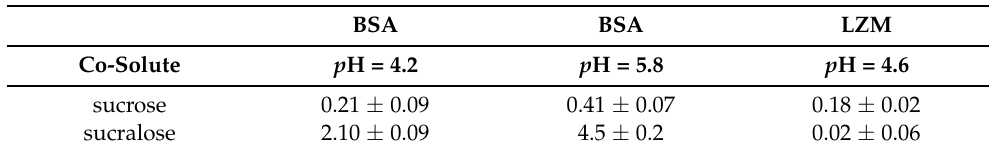
Table 2. Stern-Volmer quenching constants ( K SV ) in L mol − 1 for BSA ( p H = 4.2 and p H = 5.8) and lysozyme (LZM; p H = 4.6) in the presence of sucrose and